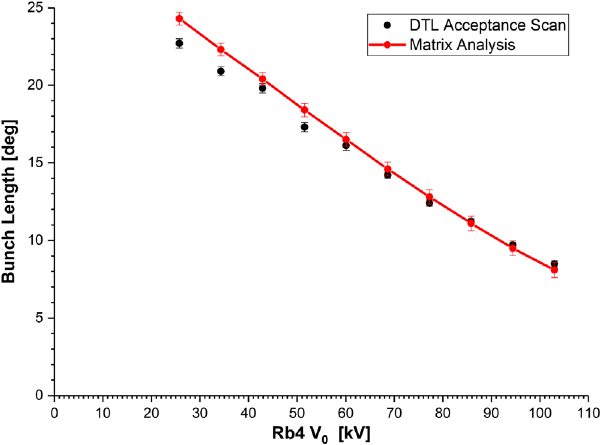
FIG. 5. The bunch length at the end of MEBT vs Rb4 Fig. 3 is not a perfect vertical line, and the real ellipse describing the bunch in this phase space is tilted. Despite